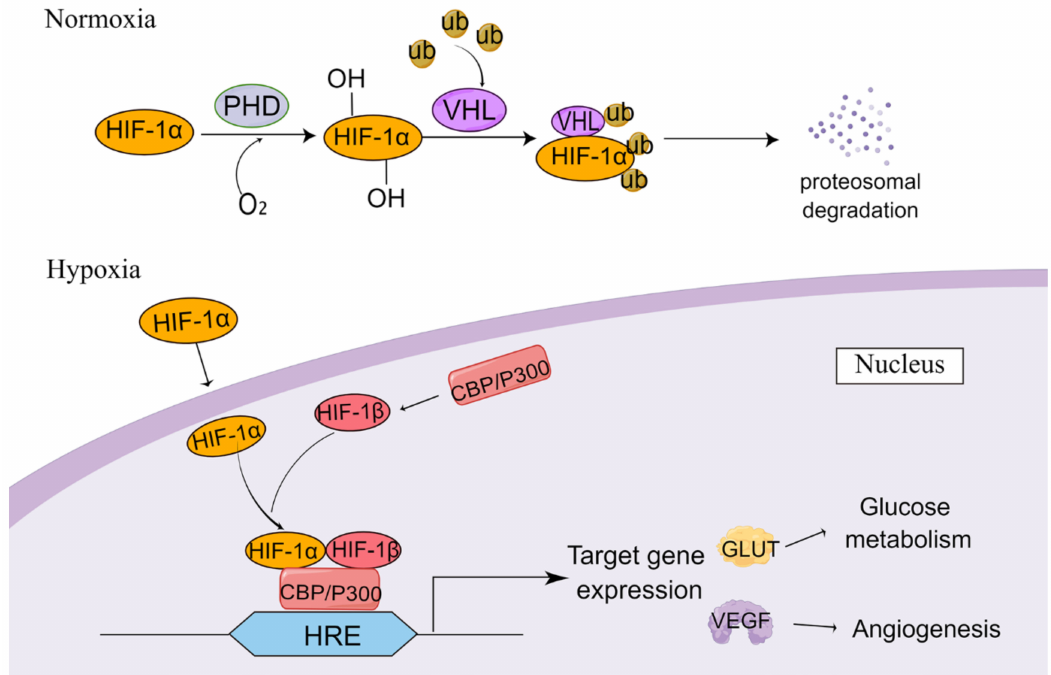
Figure A2. Under normoxic conditions, translated HIF-1 α is recognized by PVHL proteins after the hydroxylation of its proline residues (Pro-402 and Pro-564) by PHD proteins, after which the PVHL protein recruits ubiquitin ligase to bind to HIF-1 α , and the HIF-1 α bound to ubiquitin ligase enters the proteasome to be crushed and degraded, eventually losing its biological function. Conversely, the hydroxylation of HIF-1 α is inhibited under hypoxia; the accumulated HIF-1 α enters the nucleus, binds to another partner HIF-1 β to form a dimer, and, with the help of coactivators such as CBP/P300, activates VEGF, GLUT1, and other target genes’ transcriptional expression, thereby performing critical biological functions such as promoting hypoxia-induced angiogenesis, cell metabolism, proliferation, invasion, metastasis, etc. Abbreviations: PVHL: von Hippel–Lindau; PHDs: prolyl hydroxylase do- main; CBP/P300: cAMP response element-binding, protein-binding protein; HRE: hypoxia response element; VEGF: vascular endothelial cell growth factor; GLUT1: Glucose transporter